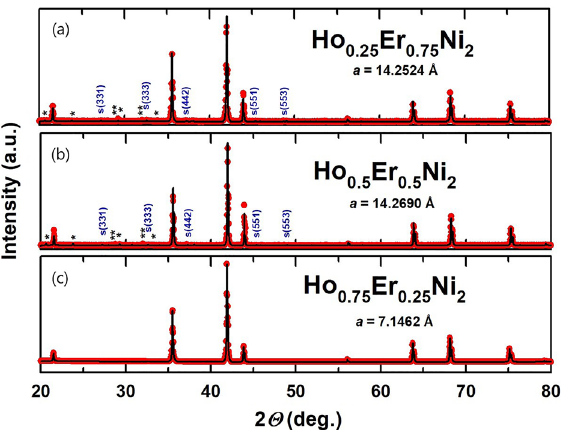
Figure 1. Results of the Rietveld refinement of the room-temperature XRD patterns taken for Ho 0.25 Er 0.75 Ni 2 ( a ), Ho 0.5 Er 0.5 Ni 2 ( b ) and Ho 0.75 Er 0.25 Ni 2 ( c ). Peaks marked with S correspond to the superstructure ( F -43 m space group) and peaks for the rare-earth (Ho,Er) 2 O 3 oxide phases are marked with * and